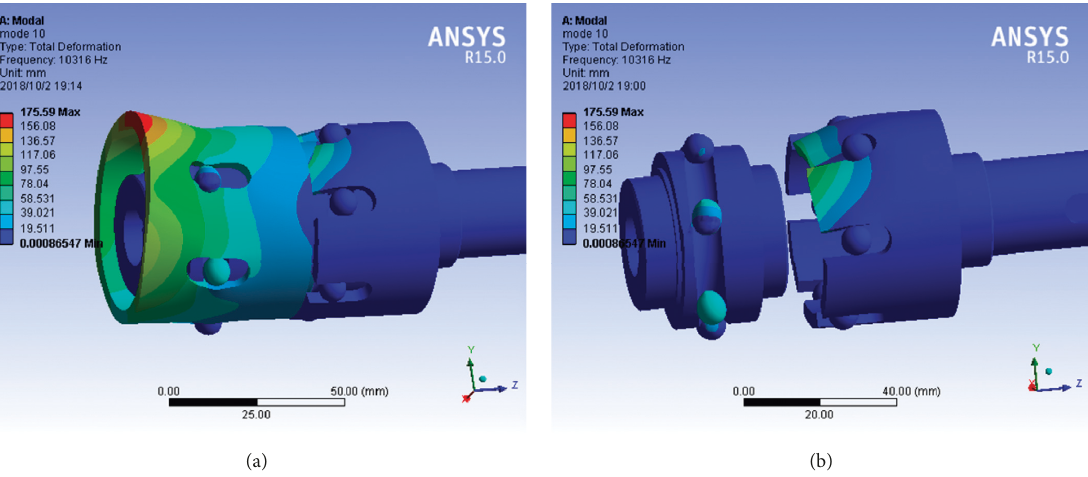
Figure 7: Four-element vibration mode (mode 10).